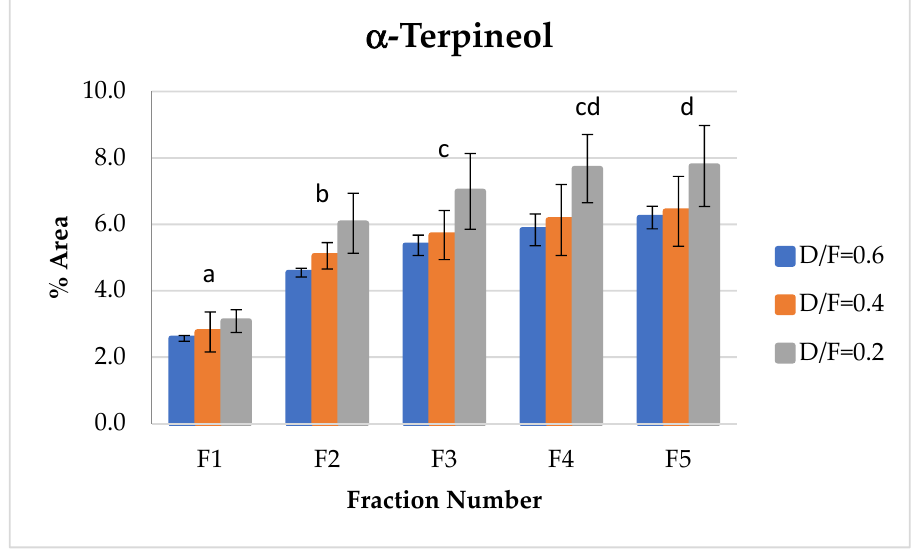
Figure 9. Abundance profile vs. number fraction for α -terpineol. The results are the average of three replicates ± standard deviation. Different letters over a column indicate statistical differences (Tukey, p < 0.05).